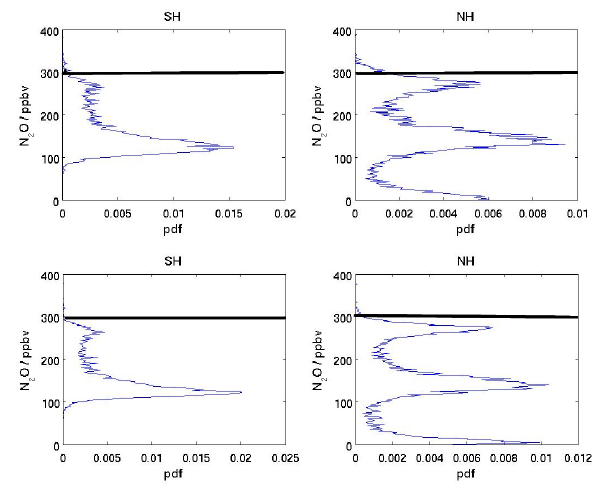
Fig. 9. Probability density functions (PDFs) derived for Odin/SMR measurements (NH and SH) with Odin/SMR vertical resolution (1.5km, top) and reduced to MLS vertical resolution (4km, bottom) for January 2003 at 650K. The black solid lines mark where N 2 O exceeds